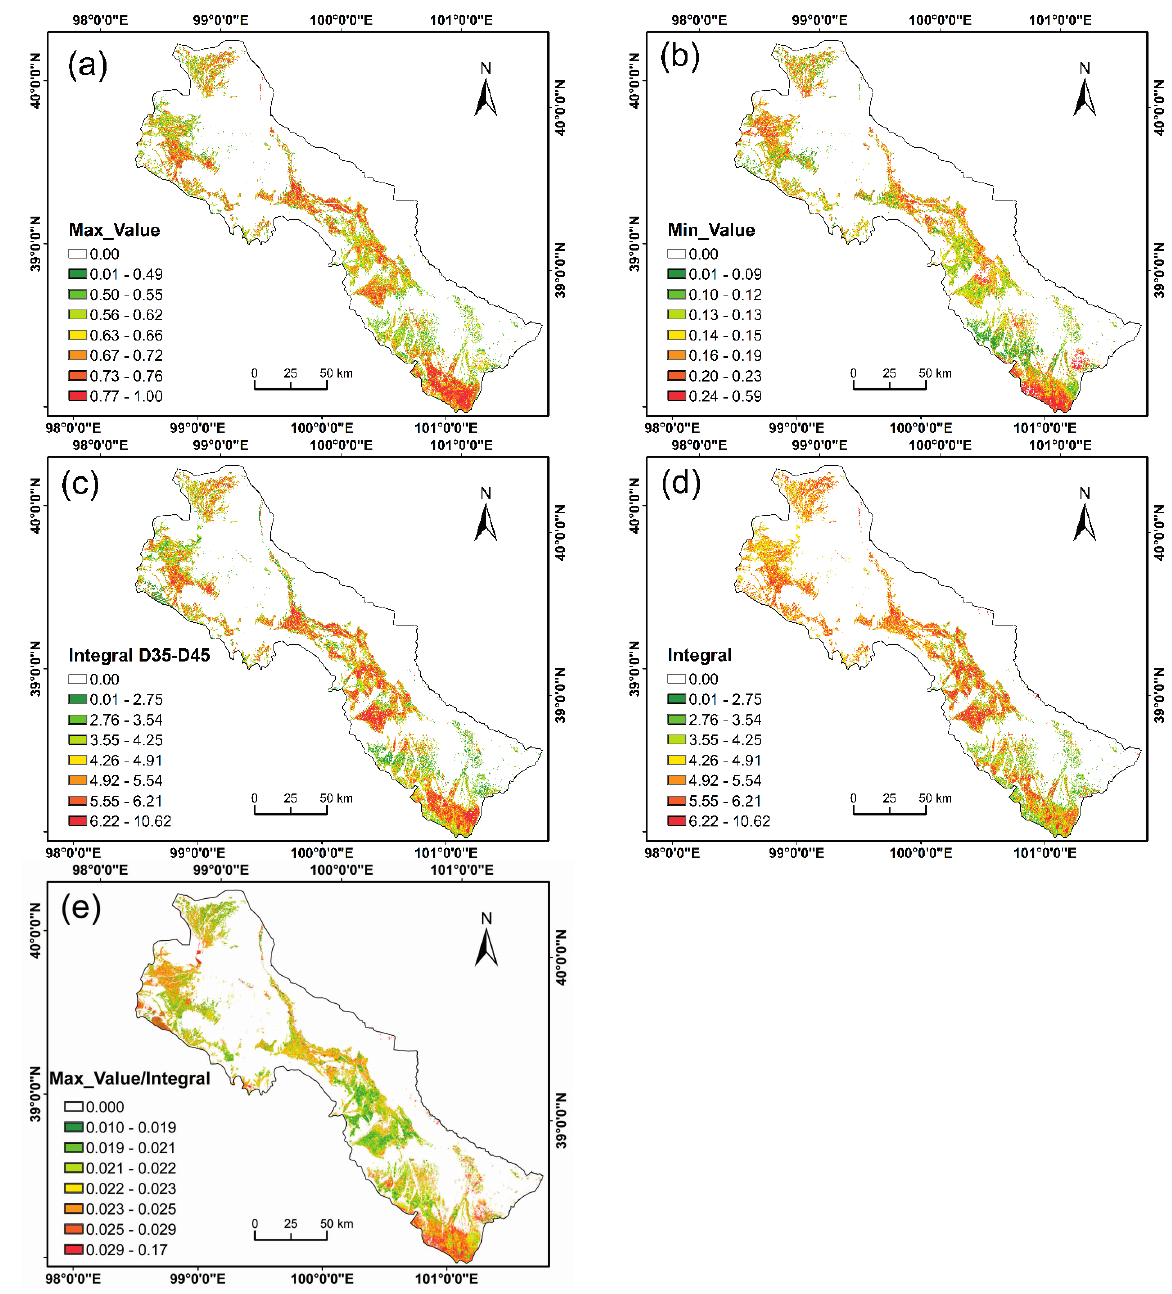
Figure 13. The maps of the selected features for the C3 and C4 vegetation classification. ( a ) the maximum NDVI value of the growing season; ( b ) the minimum NDVI value of the growing season; ( c ) the integral of NDVI between DOY 35 and DOY 45; ( d ) integral of NDVI for the growing season; and ( e ) the ratio between maximum NDVI and the integral of NDVI within the growing